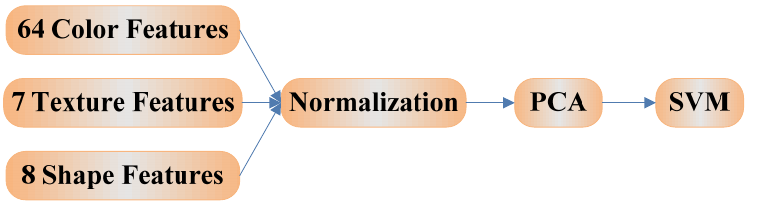
Figure 4. Using normalization before